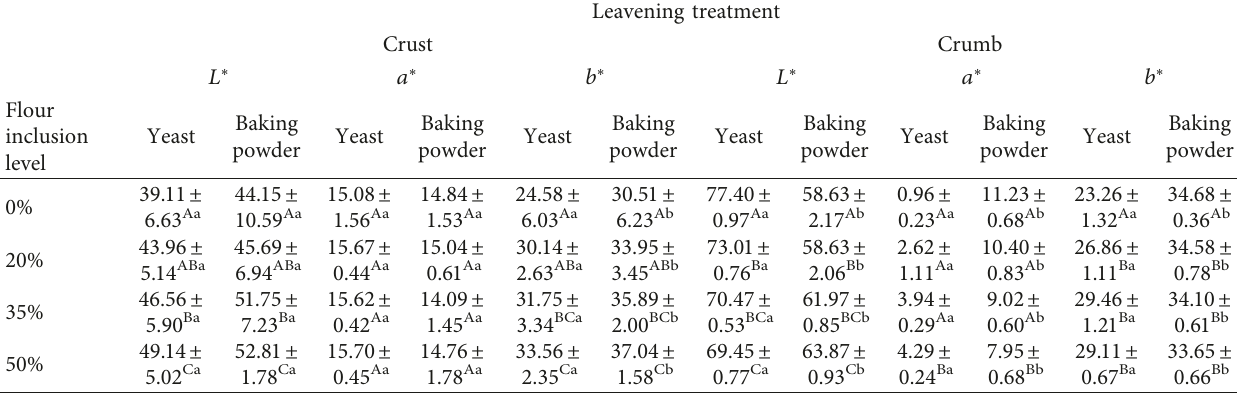
Table 4: L ∗ , a ∗ , and b ∗ color values of experimental gluten-free bread formulas. Leavening treatment